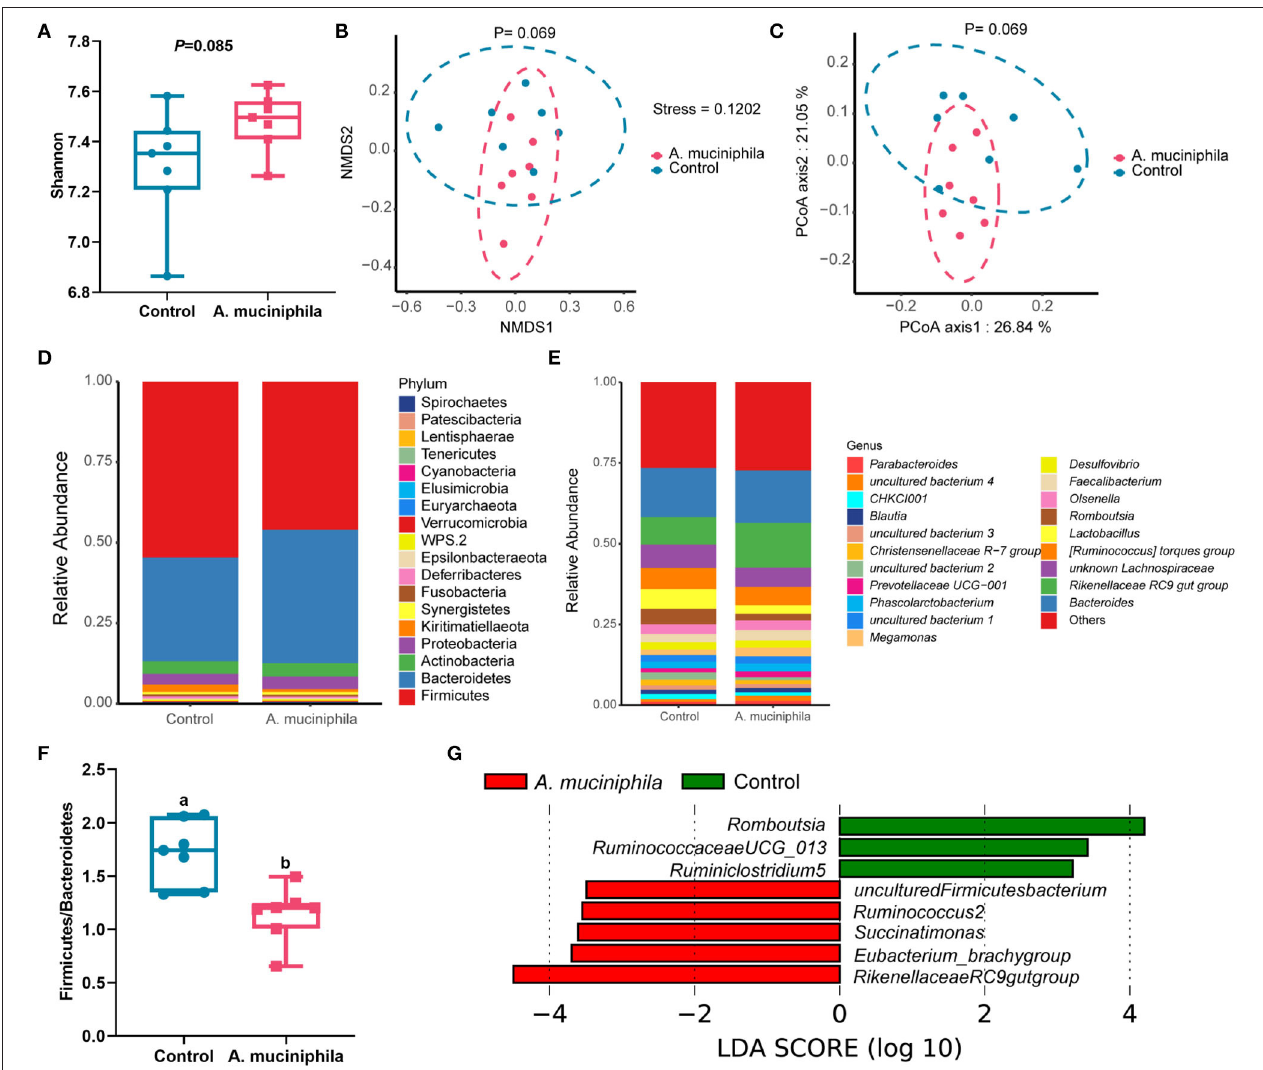
FIGURE 8 | Akkermansia muciniphila supplementation reshaped the composition of the gut microbiota in aged laying hens ( n = 7). (A) Determination of gut microbiota diversity (as measured by the Shannon index). (B) Non-metric multidimensional scaling (NMDS) analysis. (C) Principal coordinates analysis (PCoA). (D) Taxonomic analysis of the gut microbiota at the phylum level. (E) Taxonomic analysis of the gut microbiota at the genus level. (F) Ratio of Firmicutes to Bacteroidetes . (G) The linear discriminant analysis (LDA) score showed a significant difference in bacterial composition between the control group and the A. muciniphila -treated group. Different letters indicate significant differences at p <